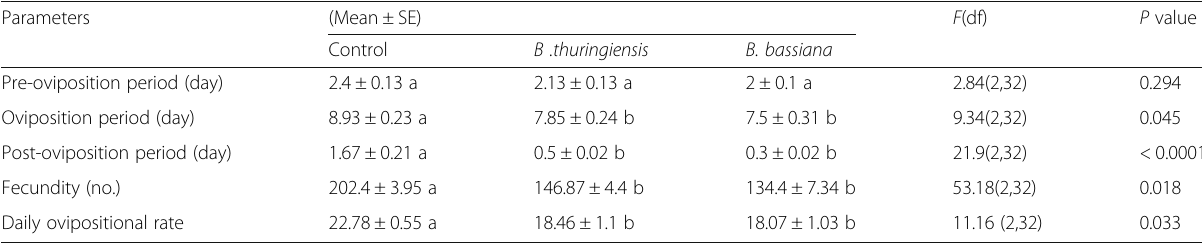
Table 5 Oviposition periods and fecundity (mean ± SE) of T. absoluta treated as second instar larvae by LC 50 values of B. thuringiensis or B.